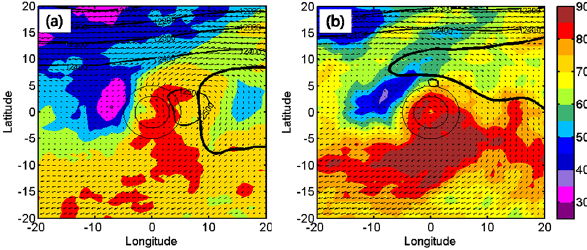
Figure 10. GFS-derived fields for the composites of vector winds, RH (shading), geopotential height (contours, 100gpm intervals starting at 12100gpm) at 200hPa, and geopotential height of 5880m at 500hPa (thick black line) for (left) weakening and (right) strengthening events at time t + 48h . The two black solid circles are 3 ◦ - and 5 ◦ -radius circles centered on the storm.